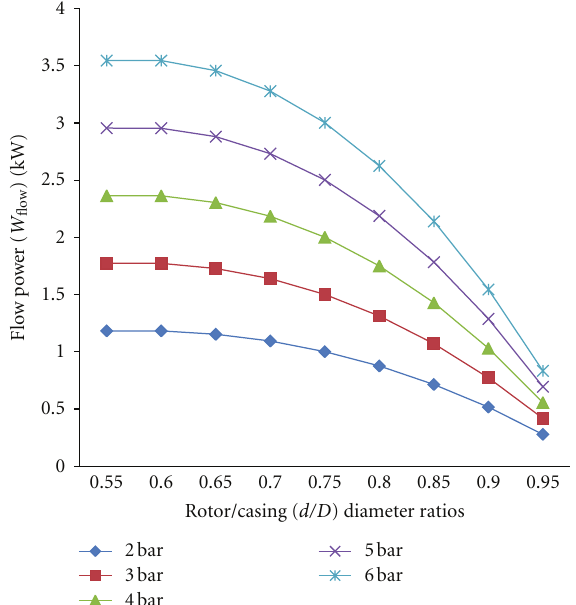
Figure 5: Percentage contribution of expansion power versus rotor/ casing diameter ( d/D ) ratio, when D = 100mm.